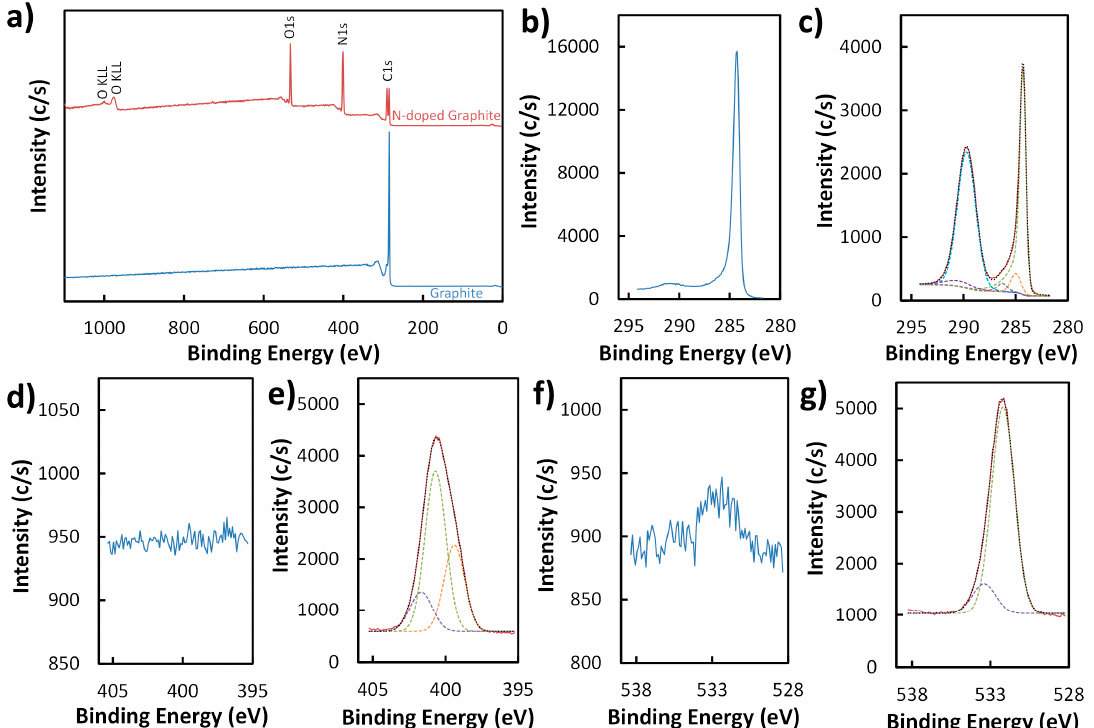
Figure 2. XPS survey ( a ) and high-resolution ( b – g ) spectra of graphite (blue) and N-doped graphite (red). High-resolution spectra display the C1s ( b , c ), N1s ( d , e ), and O1s ( f , g ) regions for graphite ( b , d , f ) and N-doped graphite ( c , e , g ). Models (black dotted lines) of C1s ( c ), N1s ( e ), and O1s ( g ) peaks for N-doped graphite (solid red lines) based on deconvolution of the peaks into their major components (green, purple, orange, gray, and light blue dashed lines) are also shown.